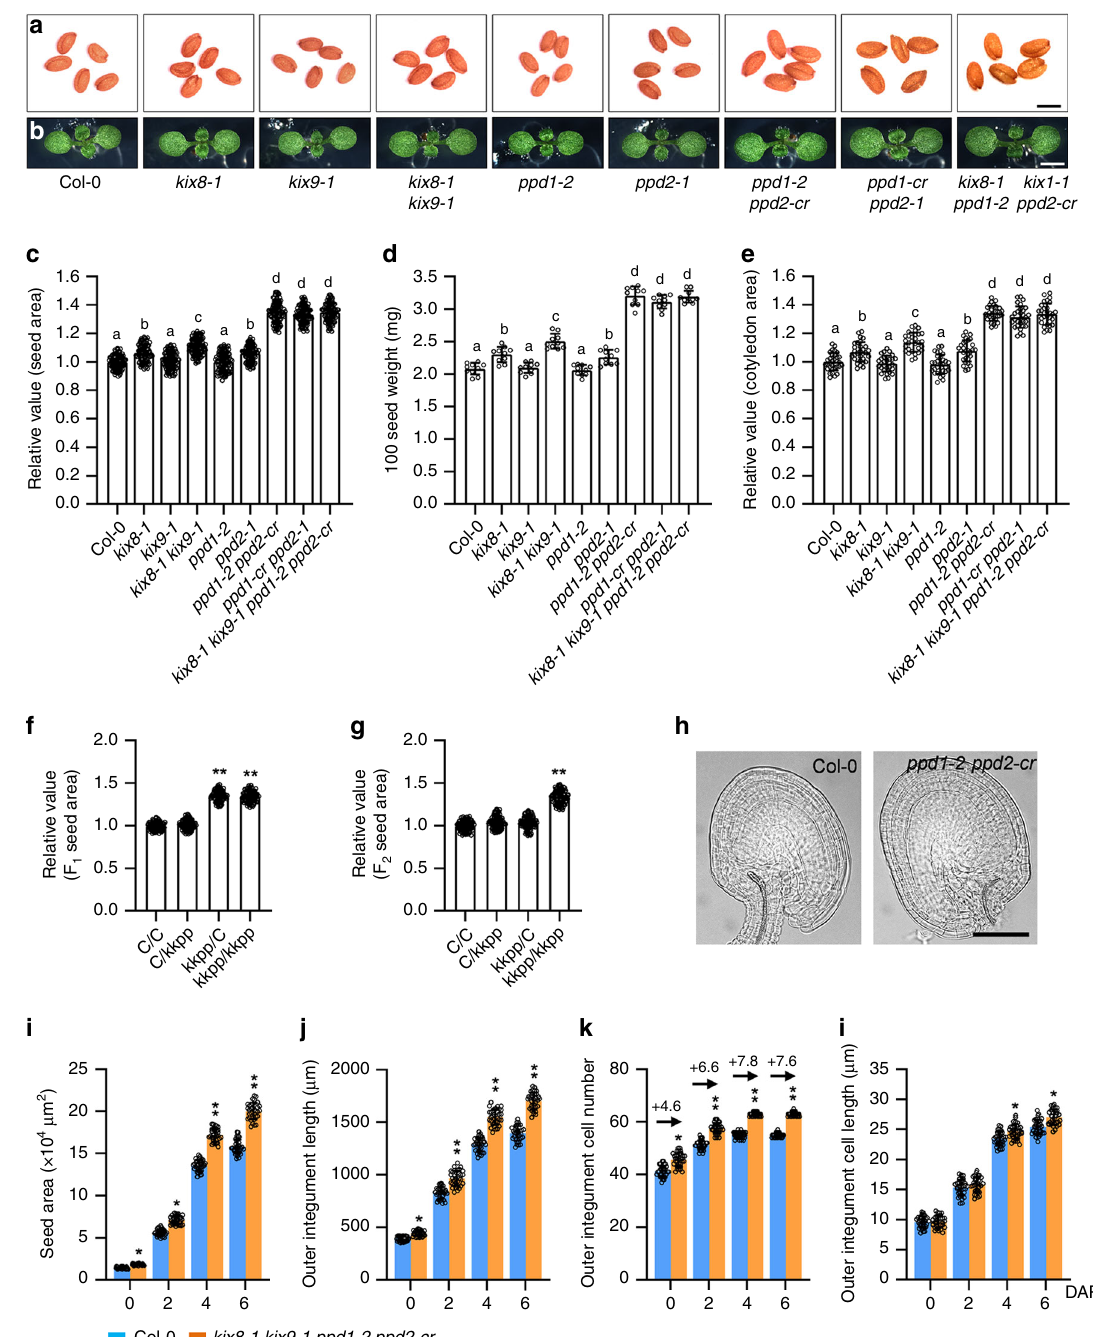
Fig. 1 The KIX-PPD complex acts maternally to control seed development. a , b The seeds ( a ) and 8-day-old seedlings ( b ) of Col-0, kix8 - 1 , kix9 - 1 , kix8 - 1 kix9 - 1 , ppd1 - 2 , ppd2 - 1 , ppd1 - 2 ppd2 - cr , ppd1 - cr ppd2 - 1 , and kix8 - 1 kix9 - 1 ppd1 - 2 ppd2 - cr plants. c – e The relative seed area ( c , n = 100), 100 seed weight ( d , n = 10), and cotyledon area ( e , n = 30) of Col-0, kix8 - 1 , kix9 - 1 , kix8 - 1 kix9 - 1 , ppd1 - 2 , ppd2 - 1 , ppd1 - 2 ppd2 - cr , ppd1 - cr ppd2 - 1 , and kix8 - 1 kix9 - 1 ppd1 - 2 ppd2 - cr . Seeds from the third to seventh silique on the stem of six plants were used for analysis. Cotyledons from the 8-day-old seedlings were used for analysis. f , g The relative area of F 1 seeds ( f ) and F 2 seeds ( g ) from Col-0/Col-0 (C/C), Col-0/ kix8 - 1 kix9 - 1 ppd1 - 2 ppd2 - cr (C/kkpp), kix8 - 1 kix9 - 1 ppd1 - 2 ppd2 - cr /Col-0 (kkpp/C), and kix8 - 1 kix9 - 1 ppd1 - 2 ppd2 - cr / kix8 - 1 kix9 - 1 ppd1 - 2 ppd2 - cr (kkpp/kkpp) plants ( n = 100). h Ovules of Col-0 and kix8 - 1 kix9 - 1 ppd1 - 2 ppd2 - cr plants at 0 DAP (days after pollination). i – l The seed area ( i ), outer integument length ( j ), outer integument cell number ( k ), and outer integument cell length ( l ) of Col-0 and kix8 - 1 kix9 - 1 ppd1 - 2 ppd2 - cr plants at 0, 2, 4, and 6 DAP ( n = 33). Ovules and seeds from six siliques, which were from the fourth silique on the stem of six plants, were used for analysis. Scale bars, 0.5 mm ( a ), 0.2 cm ( b ), and 50 μ m ( h ). Error bars represent ±SE. Different lowercase letters above the columns indicate the signi fi cant difference among different groups, one-way ANOVA P -values: P < 0.05. * indicates signi fi cant difference from the Col-0, one-way ANOVA P -values: * P < 0.05 and ** P < 0.01.